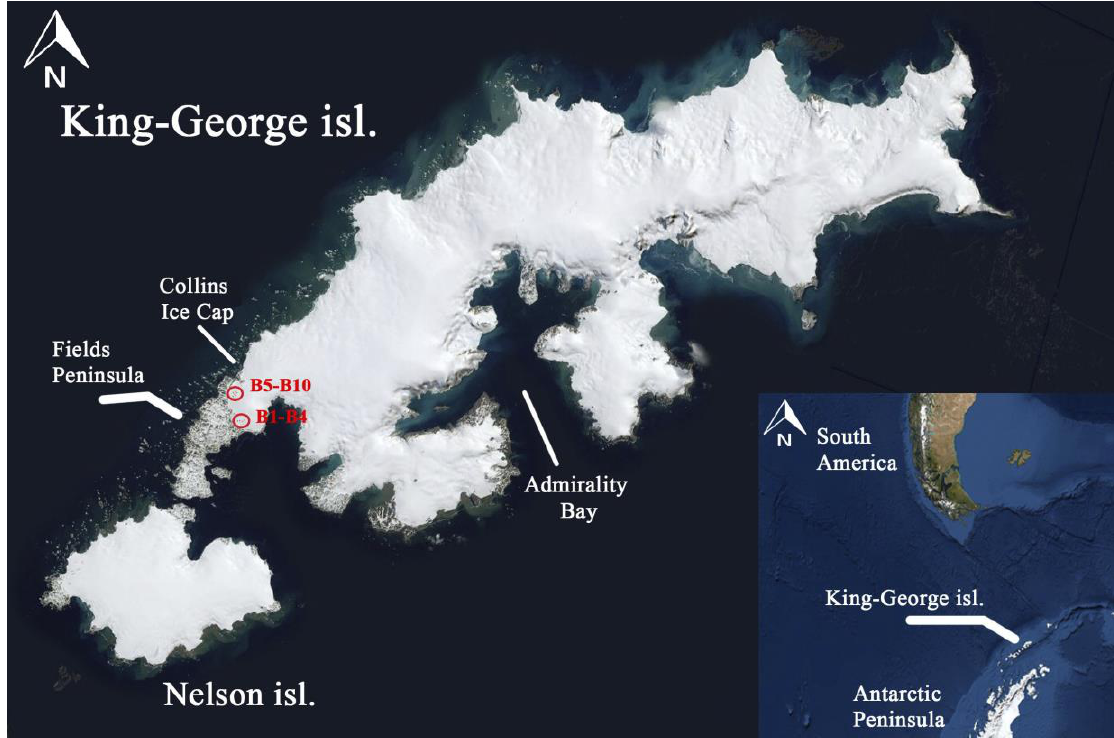
Figure 1. The study area. Fildes Peninsula, King George Island, Antarctica.